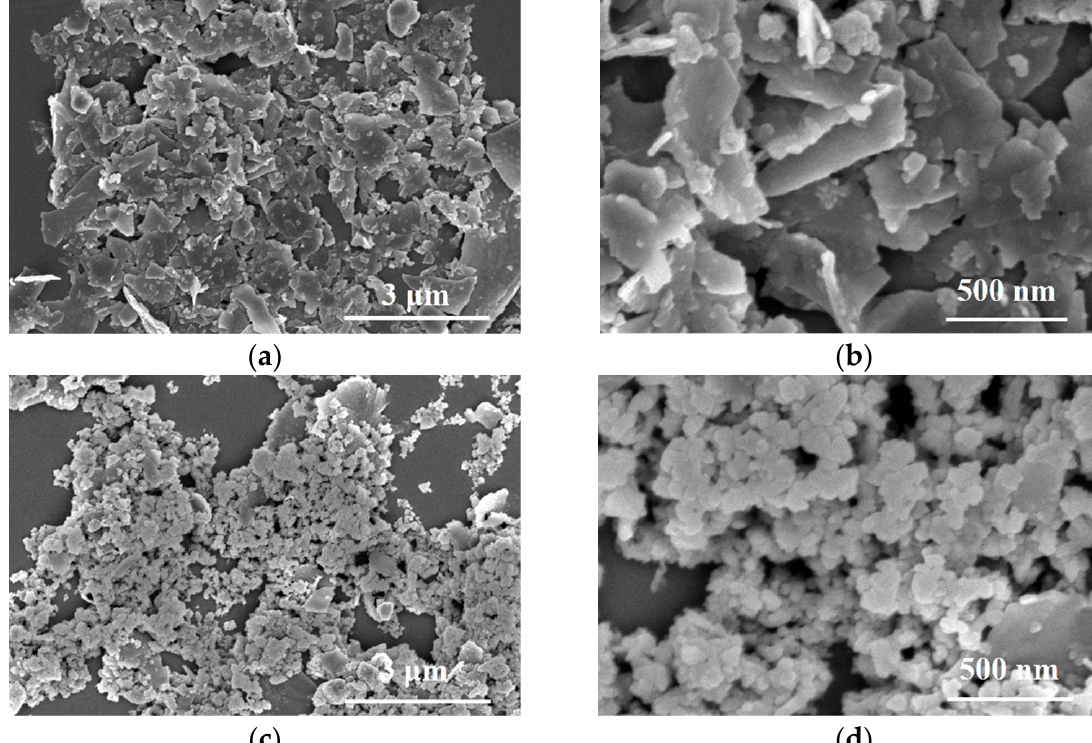
Figure 1. SEM images of MnO 2 /C: ( a , b ) sample S1; ( c , d ) sample S2 under different